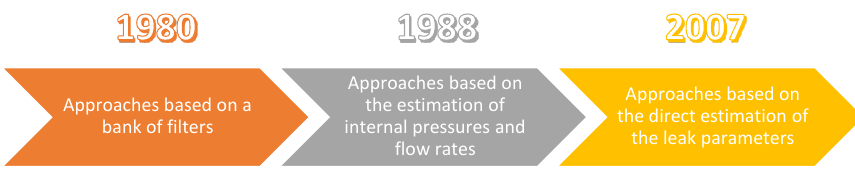
Figure 4. Timeline infographic of the evolution of the Kalman filter-based approaches.